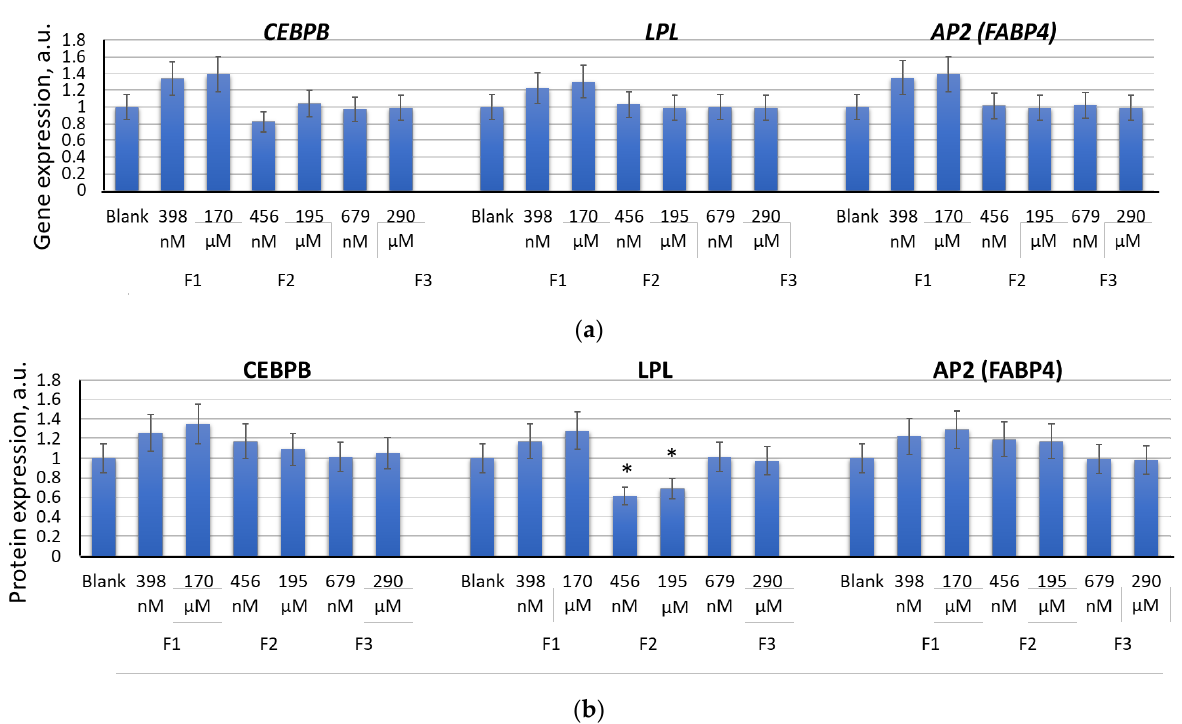
Figure 11. The effect of F1, F2, and F3 on the adipogenic differentiation genes ( a ) and proteins ( b ); the concentrations of fullerenes are shown in the figure. The gene RNA amount was the mean value for three experiments related to the blank; the TBP gene was used as an internal reference gene; FL1 values were calculated for three experiments related to the blank; (*) denotes significant differences compared to blank cells, p < 0.005, in a Mann – Whitney test. In blank experiments, cells were incubated without the fullerenes.